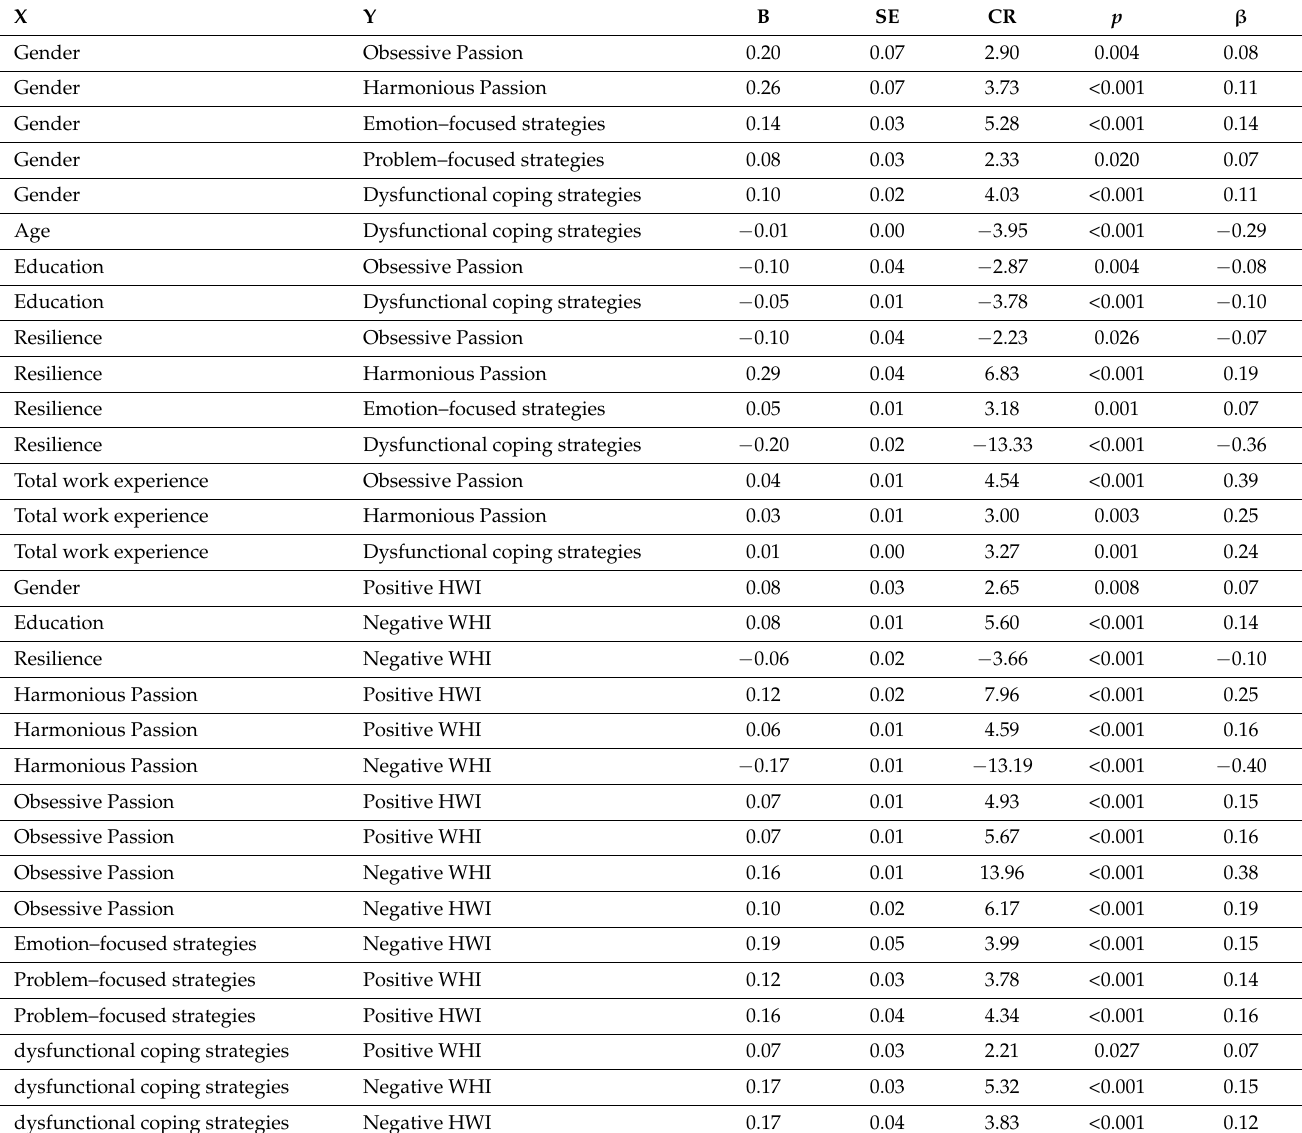
Table 5. Regression coefficients for the path